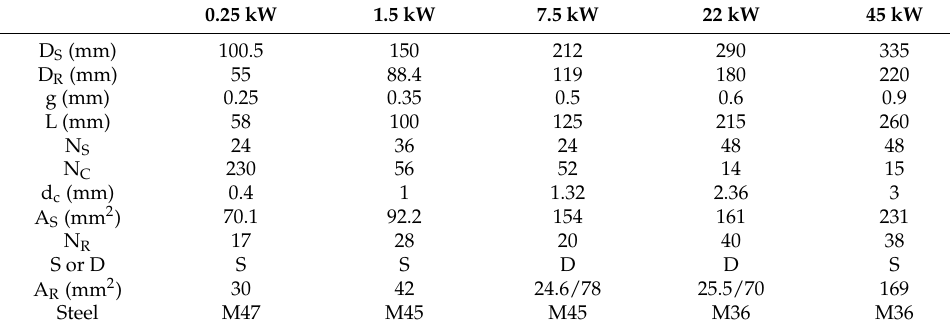
Table 2. Main dimensions of the induction